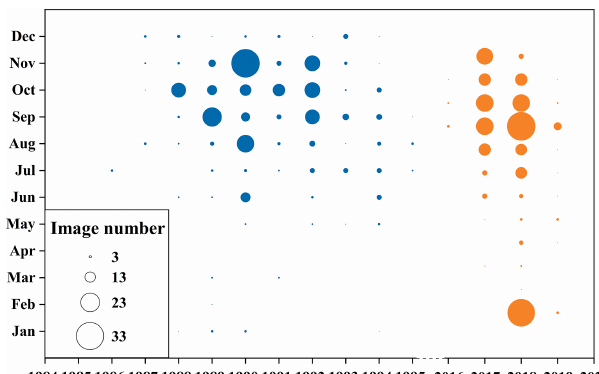
Figure 2. Time phases of remote sensing images selected for high- mountain Asia glacial lake